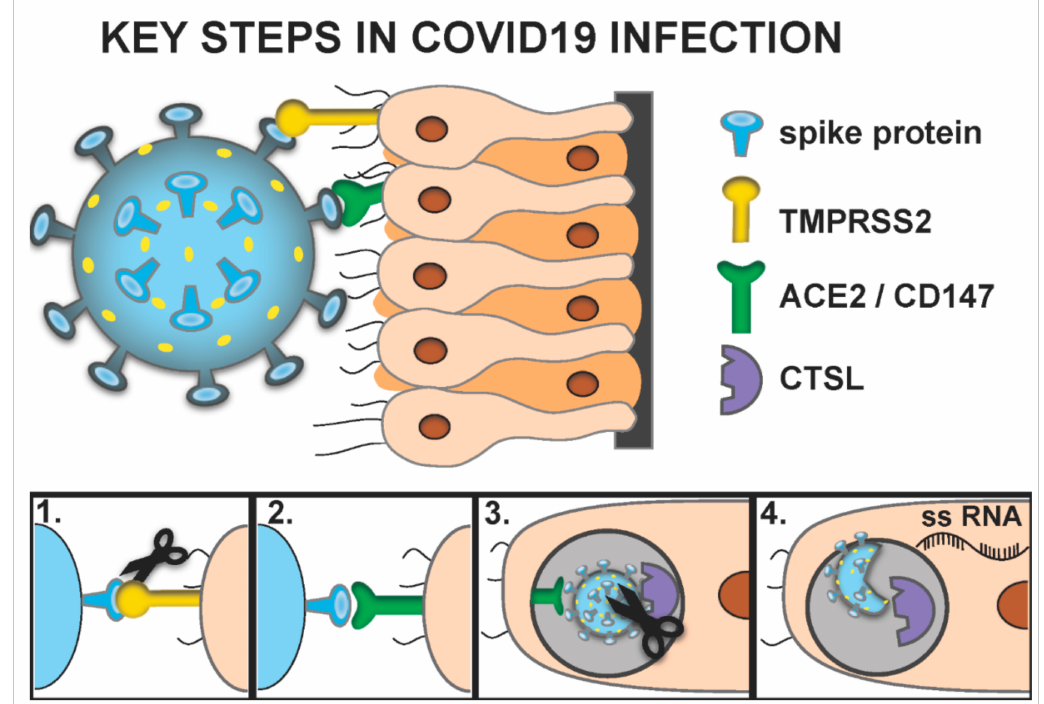
Figure 1. SARS-COV-2 infection pathway. ( 1 ). SARS-CoV-2 has a spike glycoprotein that must first be cleaved by TMPRSS2. ( 2 ). Spike protein interacts with CD147 or Angiotensin Converting Enzyme 2 (ACE-2). ( 3 ). The virus is endocytosed and cathepsin L (CTSL) must further cleave the virus. ( 4 ). The virus fuses with the endosome membrane, thereby releasing single stranded RNA (ssRNA) into the